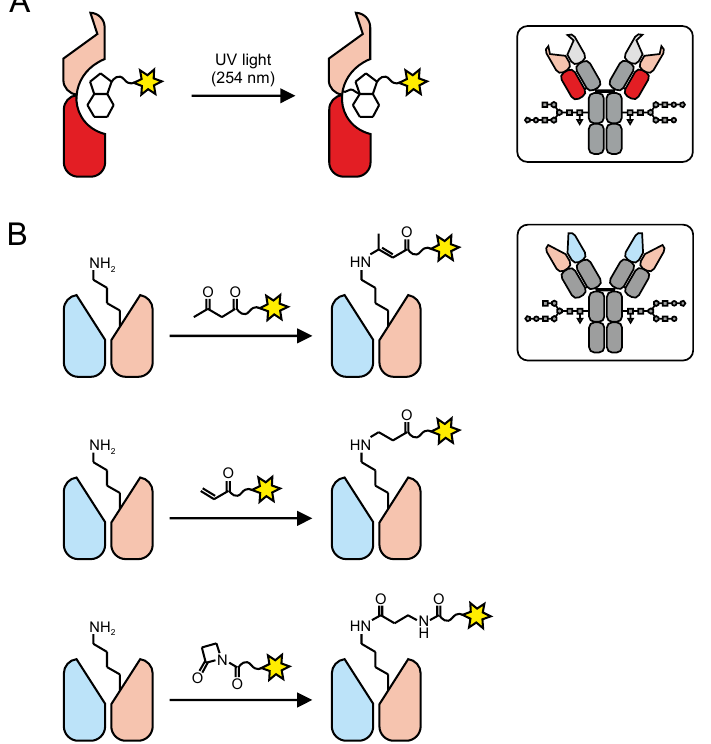
Figure 8. ( A ) General procedure for photoaffinity labeling of antibodies. A ligand of interest (yellow, star) is functionalized with a nucleotide based chemical entity. Once bound to the nucleotide binding site, irradiation with UV light will activate the nucleotide which results in the formation of a covalent bond. ( B ) The enzymatic activity of catalytic antibodies results in the formation of a covalent bond between a lysine of the catalytic site and a diketone-, vinylketone- or azetidinone-functionalized small molecular weight payload, e.g., peptide (yellow